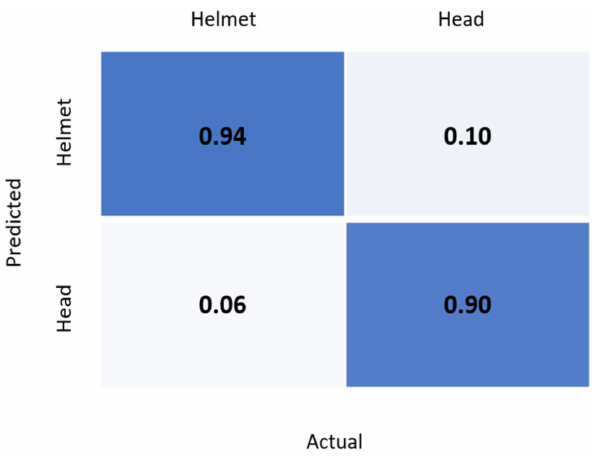
Figure 6. Confusion Matrix for Safety Helmet Detection using